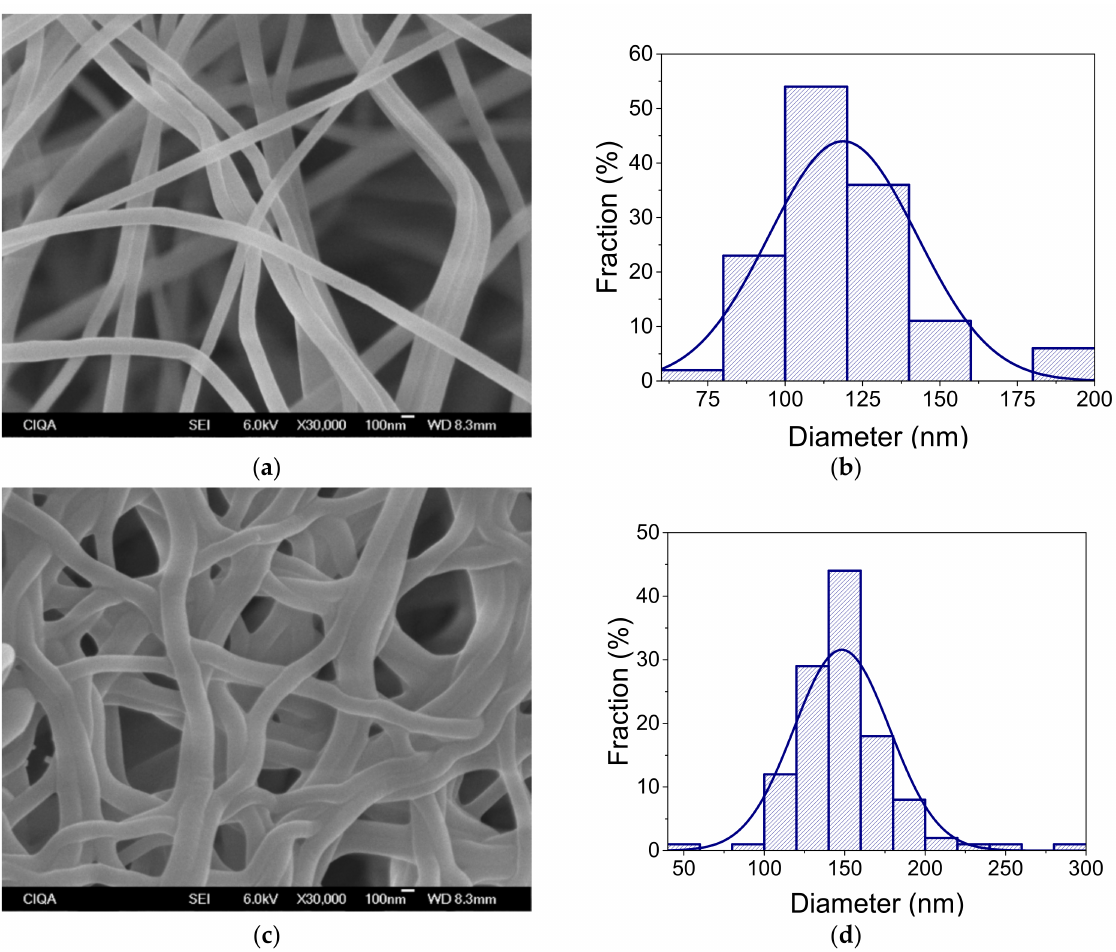
Figure 3. SEM micrographs of the PVA/ γ -PGA 10 nanofibers, obtained by electrospinning with and without cross-linking, ( a ) and ( c ), respectively. Diameter size distribution of the nanofibers with and without cross-linking, ( b ) and ( d ),